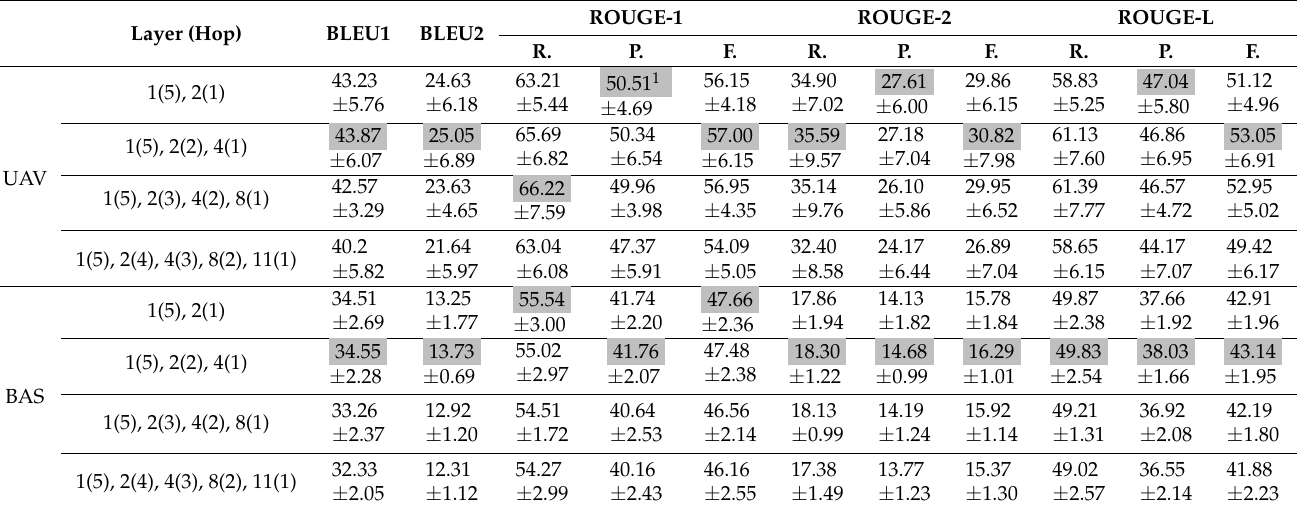
1 Grey background: Best results for each metric for each